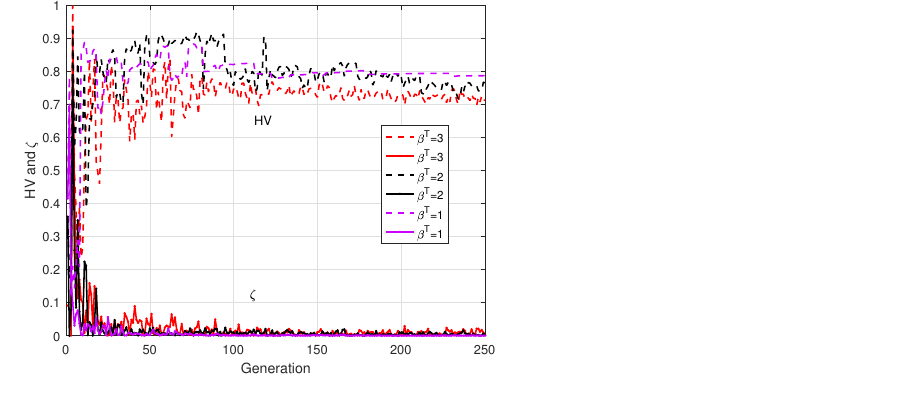
Figure 5. Progress of hypervolume and ζ of SLMDE with respect to the number of generations for example